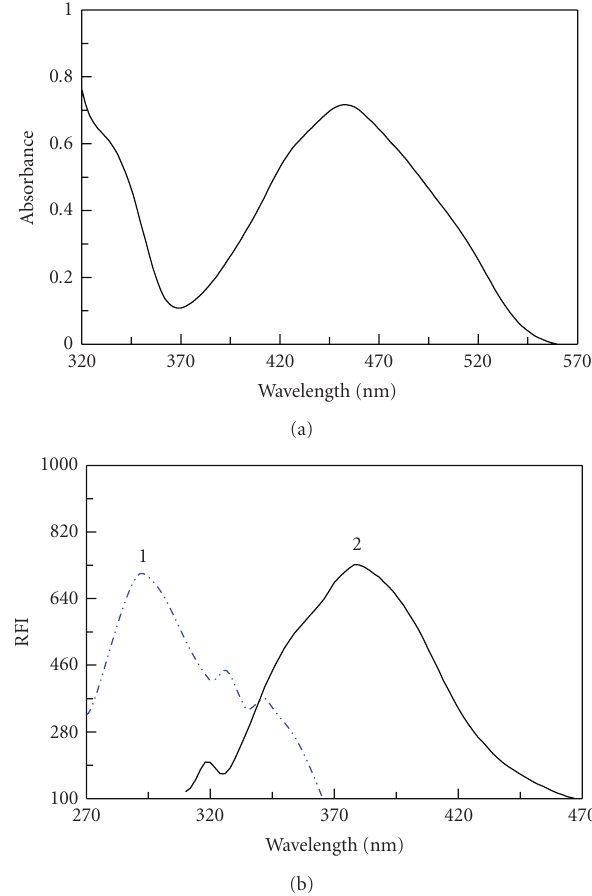
Figure 1: Absorption, excitation, and emission spectra on the reaction products of AMD with NQS (0.06%, w/v). (a) Absorption spectrum of the reaction product of AMD (65 μ g mL − 1 ) with NQS after extraction with chloroform. (b) (1) Excitation and (2) emission spectra of the reduced reaction product. RFI is the relative fluorescence